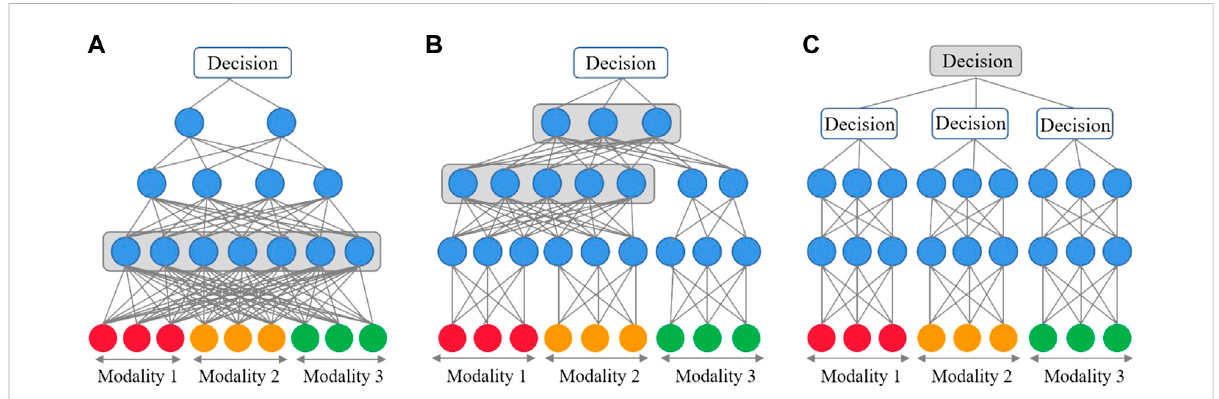
FIGURE 1 DL-based fusion strategies. Layers marked in red are shared between modalities and learned joint representations. (A) Early fusion takes concatenatedvectorsasinput; (B) Intermediatefusion fi rstlearnsmarginalrepresentationsandfusesthemlaterinsidethenetwork.Thiscanoccurin one layer or gradually. (C) Late fusion combines decisions by submodels for each